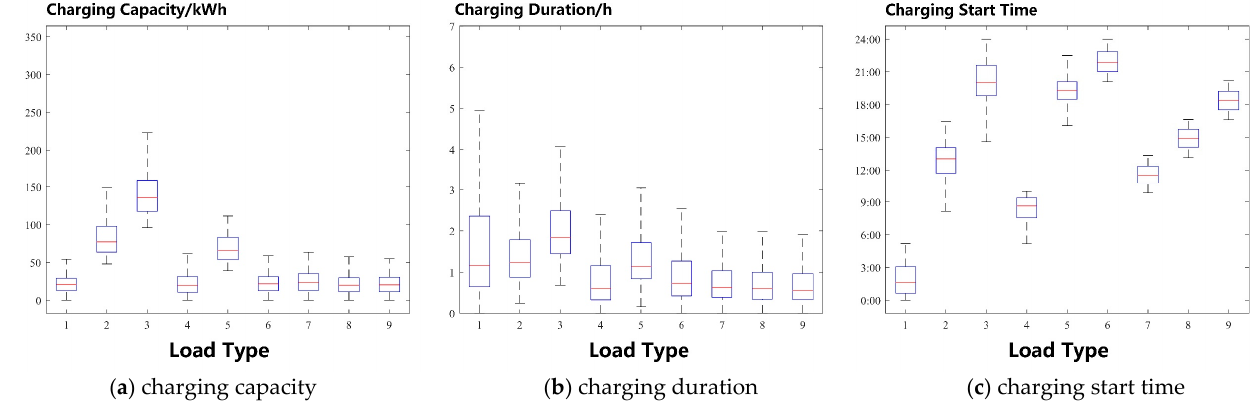
Figure 6. The box figure of each type of load.